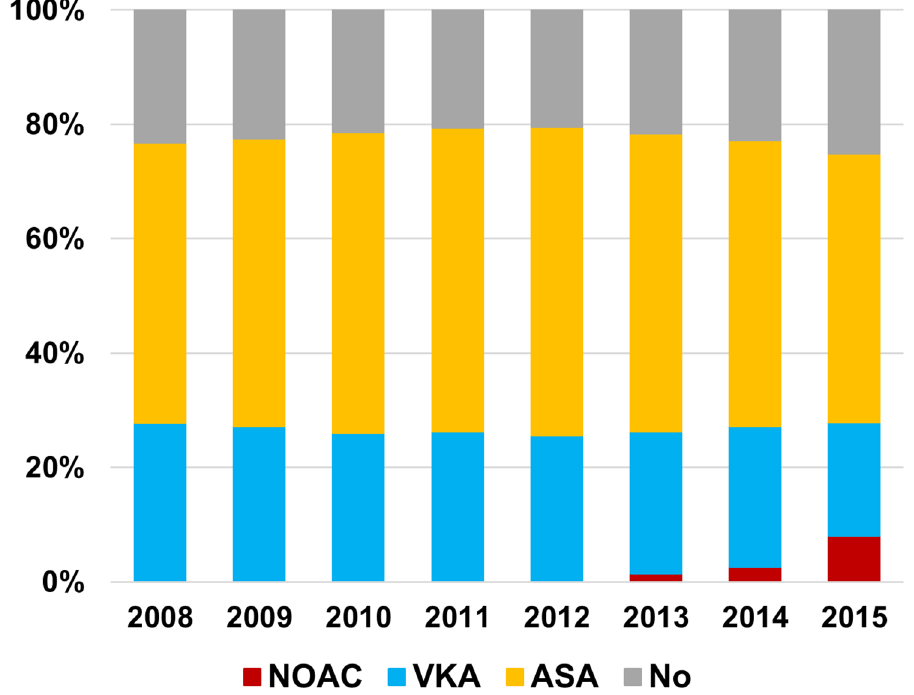
Fig 3. Temporal trends of antithrombotic therapy in men with CHA 2 DS 2 -VASc score of 1. Abbreviation: ASA, aspirin; NOAC, non-vitamin K oral anticoagulants; VKA, vitamin K antagonists.